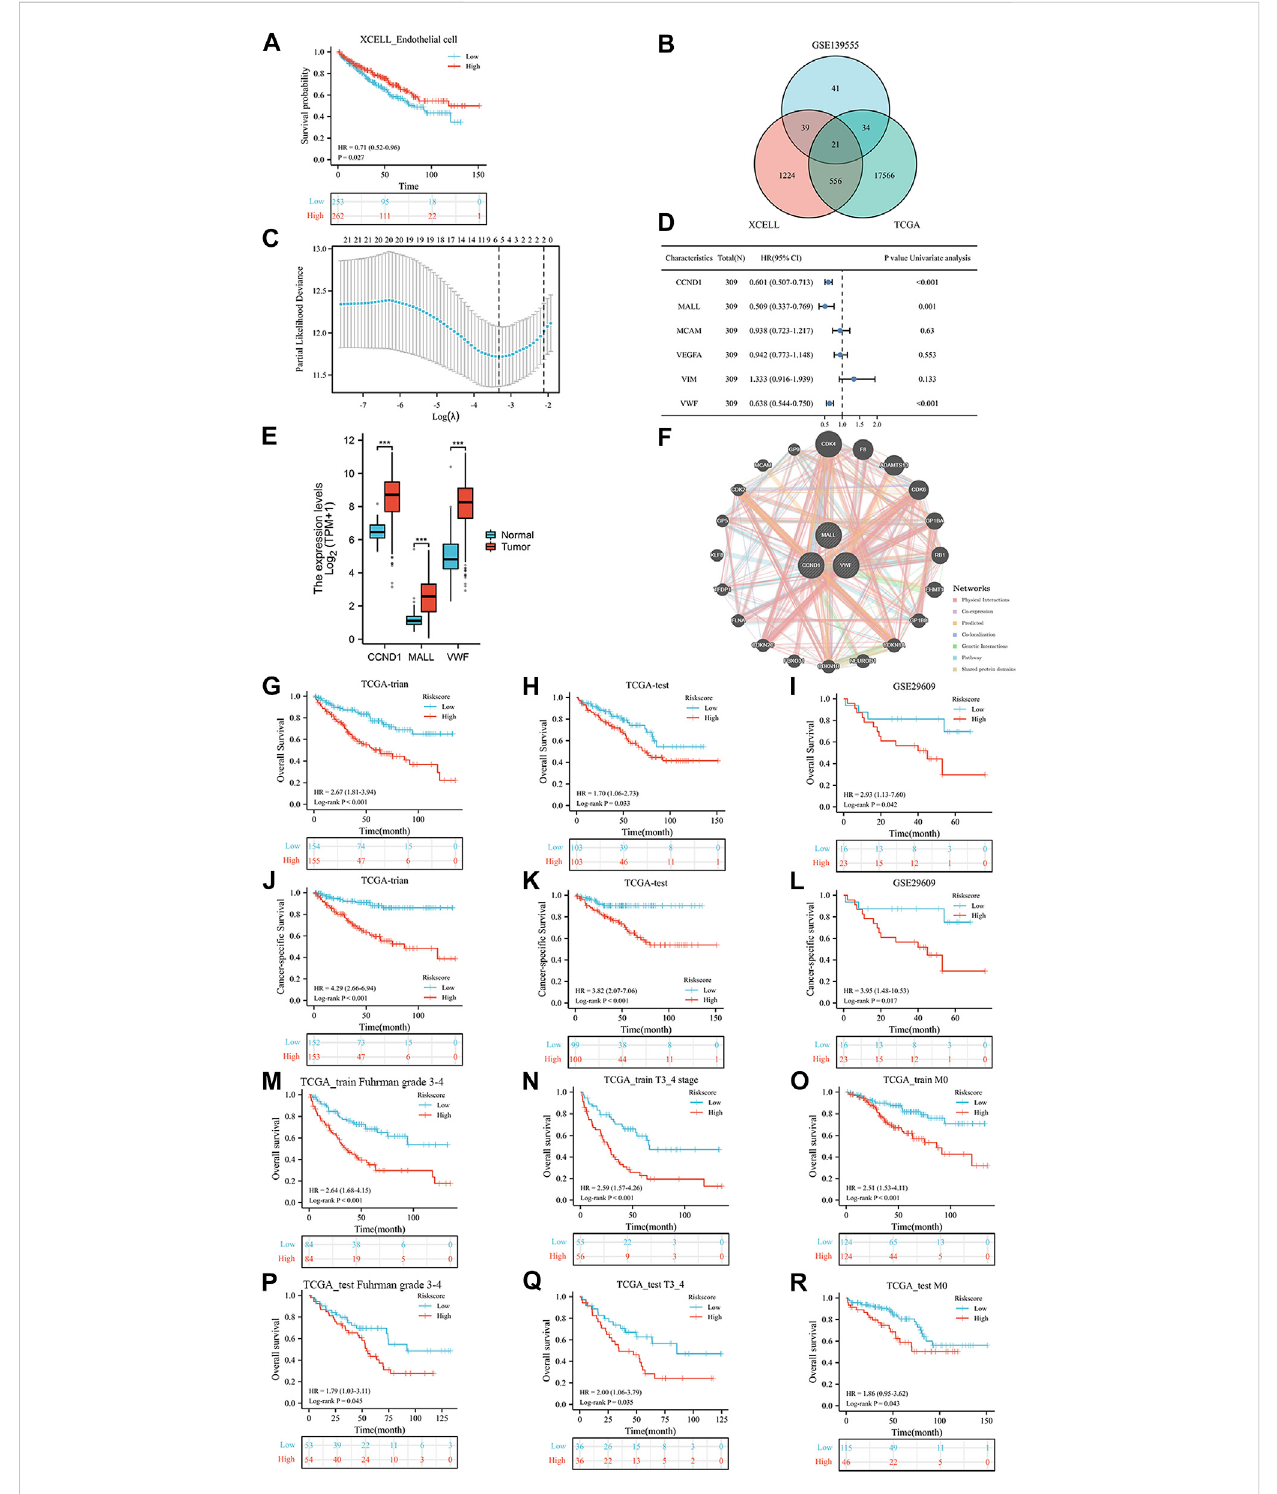
FIGURE 2 The prognostic value of endothelial cells in TCGA dataset (A) , the co-expressed genes (B) , the cross-validation to determine the optimal penalty parameter lambda (C) , the prognostic value of these six genes in overall survival (OS) according to the results of univariable Cox regression analysis in TCGA training group (D) , the expression of these three genes (E) , the protein – protein interaction network (F) , the Kaplan-Meier analysis results of OS in TCGA training group (G) , TCGA test group (H) , and GSE29609 dataset (I) ; the Kaplan-Meier analysis results of cancer-speci fi c survival in TCGA traininggroup (J) ,TCGAtestgroup (K) ,andGSE29609dataset (L) ;theKaplan-MeieranalysisresultsofOSinTCGAtrainingsubgroups:Furhmangrade3-4 (M) ,T3_4 stage (N) ,andnodistant metastasis (O) subgroups;theKaplan-Meier analysis resultsofOS inTCGA testsubgroups:Furhmangrade3-4 (P) ,T3_ 4 stage (Q) , and no distant metastasis (R)